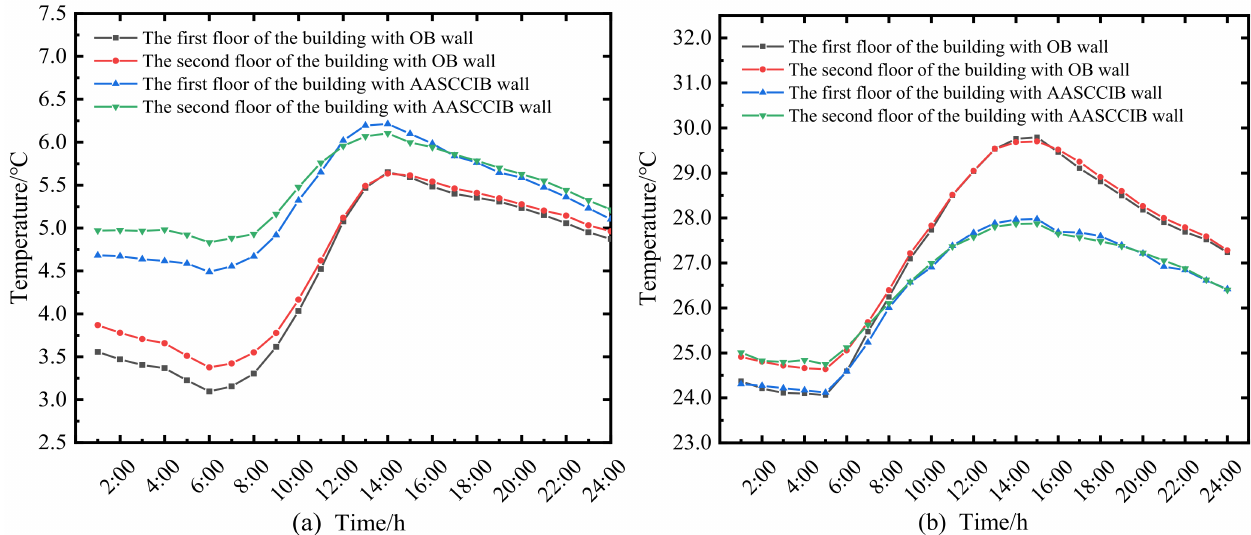
Figure 15. Indoor temperature of the building. ( a ) On the winter solstice; (b ) on the summer